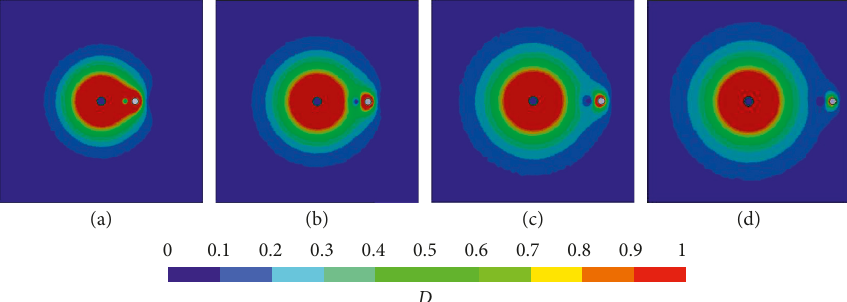
Figure 6: Damage evolution with different distances between two holes when t � 25 μ s. (a) a /2 r (d) a /2 r 1 �